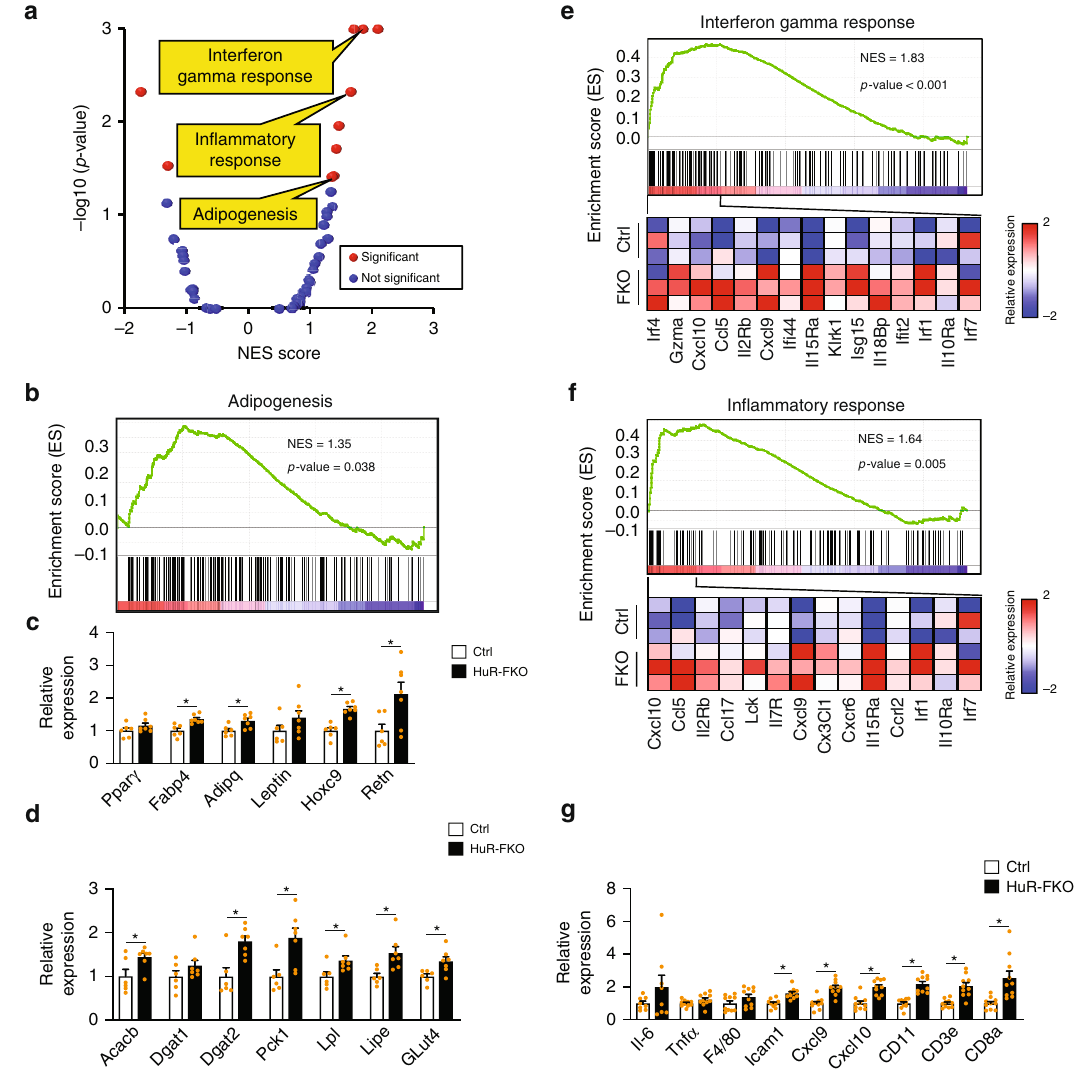
Fig. 3 HuR knockout enhances adipogenesis and in fl ammation in eWAT. a GSEA was performed to analyze the pathways affected by HuR depletion in eWAT. Scatterplot depicts the relationship between the p -value and normalized enrichment score (NES) of 50 “ Hallmark ” gene sets in MSigDB. Signi fi cant biological pathways are labeled in red. b GSEA in adipogenesis pathway. c Real-time PCR to con fi rm the expression of genes for white fat and adipogenesis (Ctrl, n = 6; HuR-FKO, n = 7). d Real-time PCR to con fi rm the expression of genes for lipogenesis and glucose uptake (Ctrl, n = 6; HuR-FKO, n = 7). e GSEA in interferon gamma response and f in fl ammatory response pathway. At the bottom of each panel shows a heatmap of representative genes found within the leading edge-subset of the biological pathway. The color intensity represents median centered gene expression (FPKM) with red and blue representing highly and lowly expressed genes, respectively. g Real-time PCR to con fi rm the expression of genes involved in in fl ammation. n = 10 per group. Error bars are mean ± SEM. Statistical signi fi cance was determined by Student ’ s t -test; * p < 0.05. Source data are provided as a Source Data fi